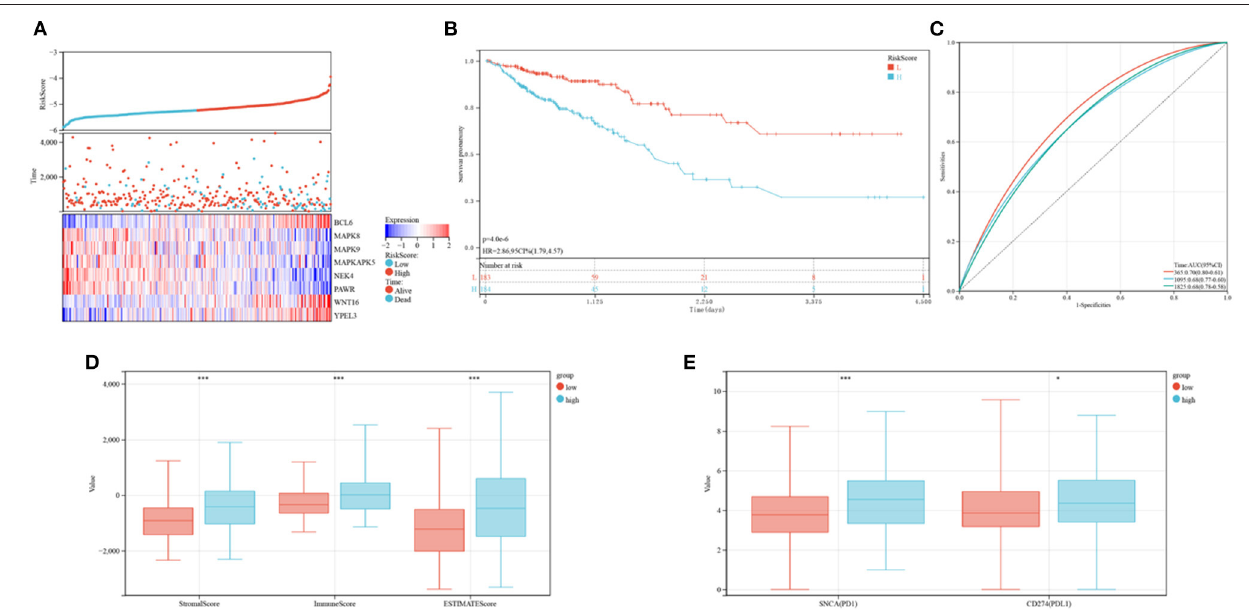
FIGURE 8 | Prognoses and immune characteristics of the low and high-risk groups in the TCGA cohorts. (A) Distribution of risk scores and survival status of CRC patients with SRG expression. (B) Kaplan-Meier analysis of OS in the low and high-risk groups. (C) ROC plots predicting the specificity and sensitivity of 1-, 3-, and